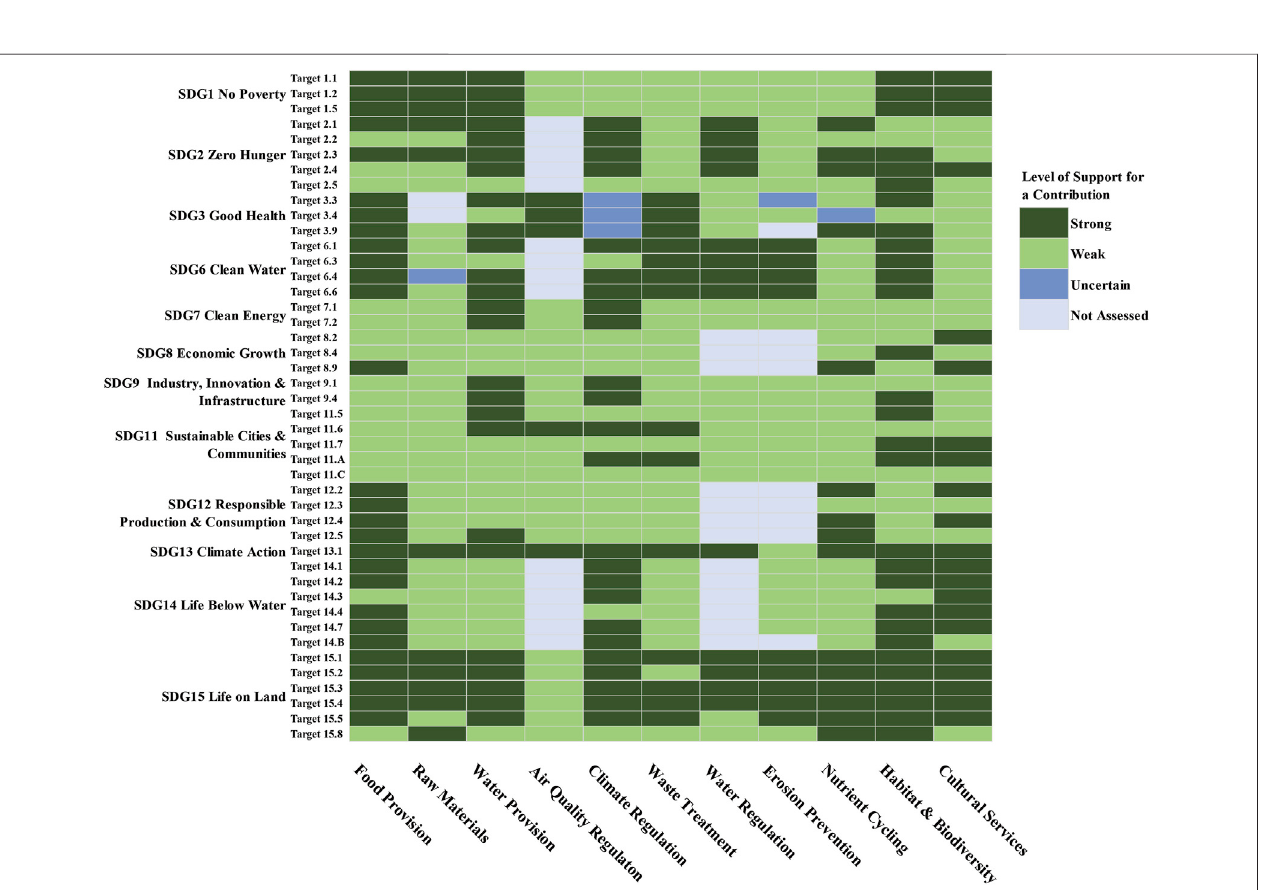
FIGURE 2 | ES-SDG linkages (modi fi ed from Wood et al., 2018).